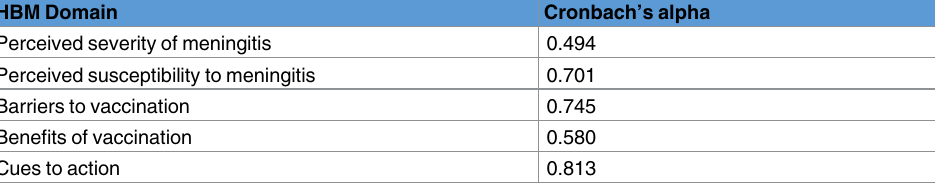
Table 1. Results of Cronbach’s alpha for Health Belief Model (HBM) survey